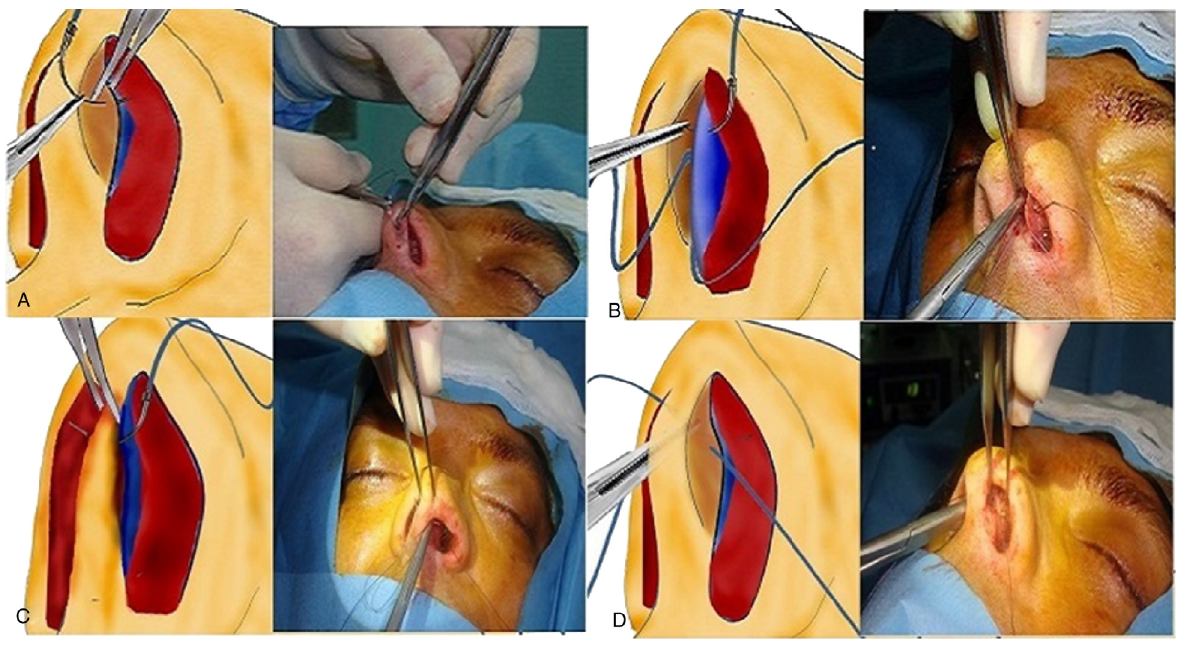
Figure 1 The sequences of the superior septocolumellar